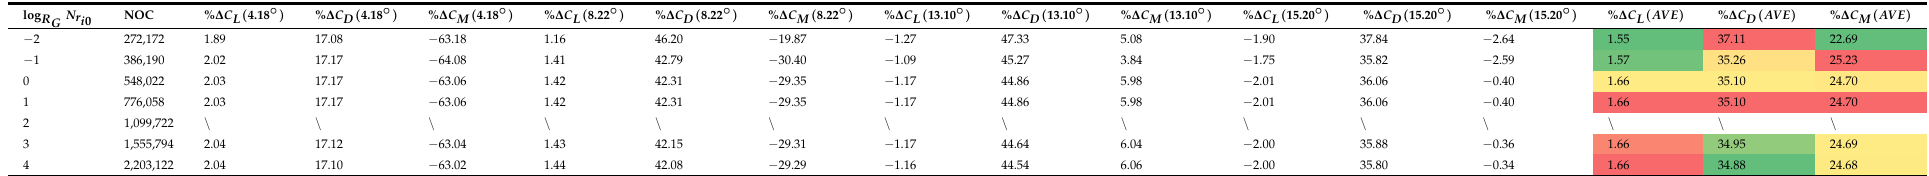
Table 17. Comparison of results of C-mesh based on various radial nodes with that of experimental benchmark data adopted from [25] in relative differences with 150 nodes in radial directions for reference setting.